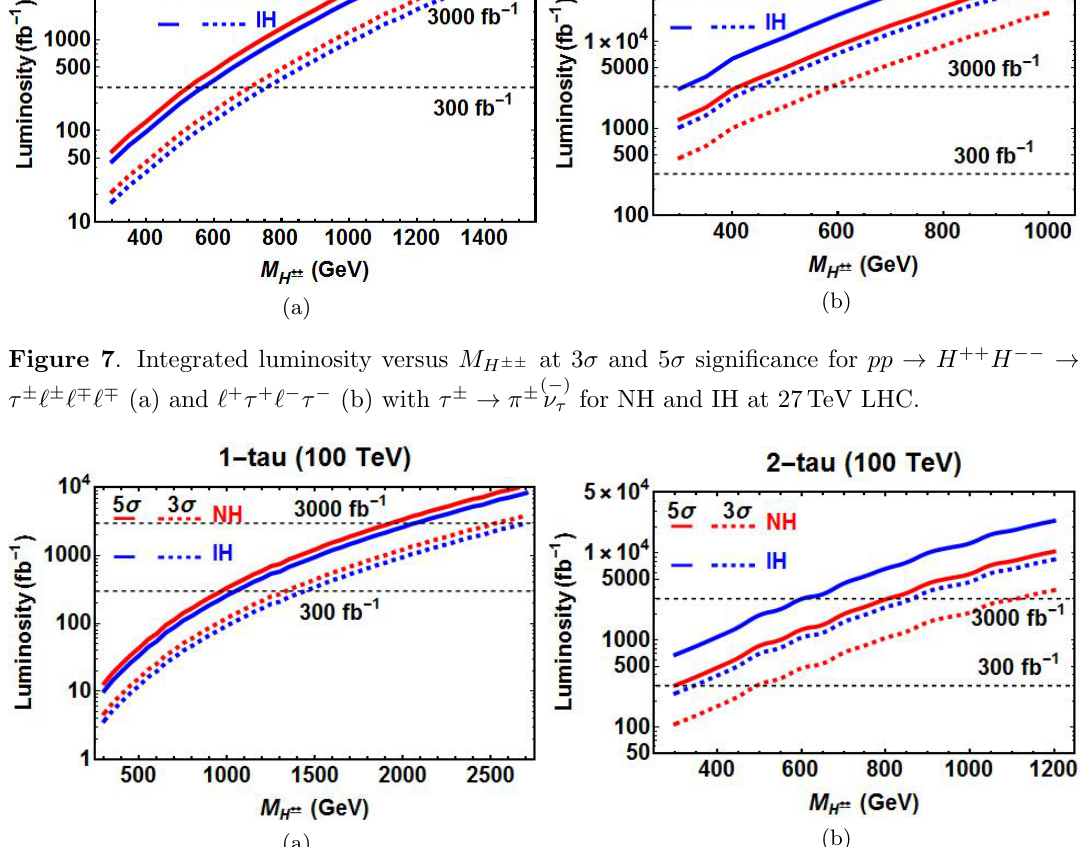
at 3 (cid:27) and 5 (cid:27) signi(cid:12)cance for pp ! H ++ H (cid:0)(cid:0) ! H (cid:6)(cid:6) ( (cid:0) ) (cid:23) (cid:28) for NH and IH at 100 TeV LHC.